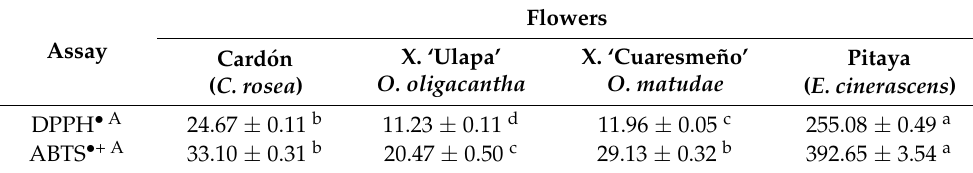
Table 3. Antioxidant activity of cactus flowers from Hidalgo, Mexico.